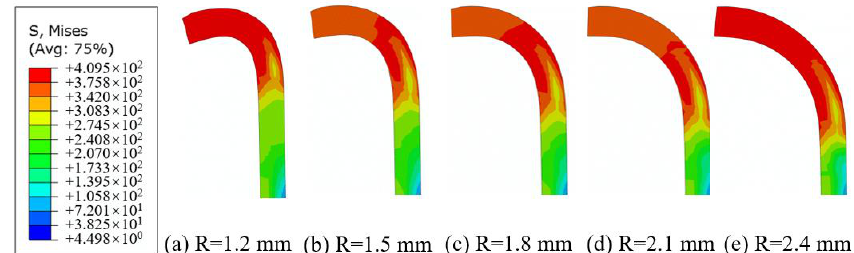
Figure 4. Effect of nosing die’s fillet radius on stamping.